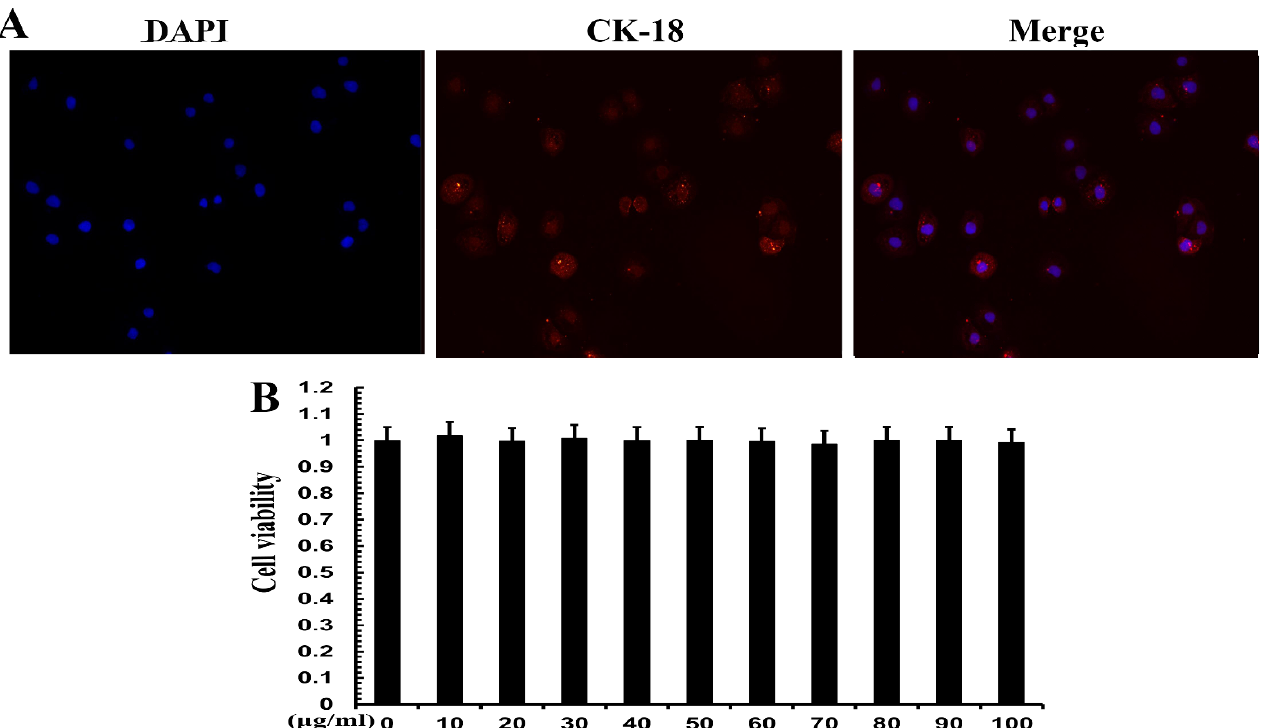
Figure 5. Cell identification and viability analysis of MAC-T cells. ( A ) Cell electron microscopy image. Blue represents the nucleus and red represents the expression of cytokeratin 18 (CK-18). ( B ) Cell viability at different concentrations. The numbers 0–100 indicate the concentration of tea polyphenols in μg/mL.